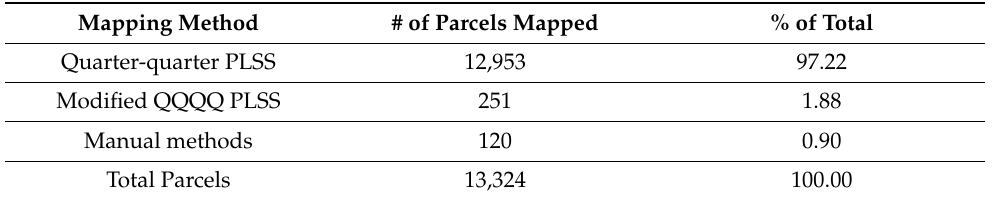
Table 3. Results of allotment mapping tool at Standing Rock. The vast majority of parcels can be mapped using only the quarter-quarter sections and government lots available in the PLSS Intersected data set. A modified quarter-quarter-quarter-quarter section file was generated on a second-pass of the tool to create the remaining small-area parcels. Manual digitization was only needed on less than 1 percent of the allotments on the reservation.